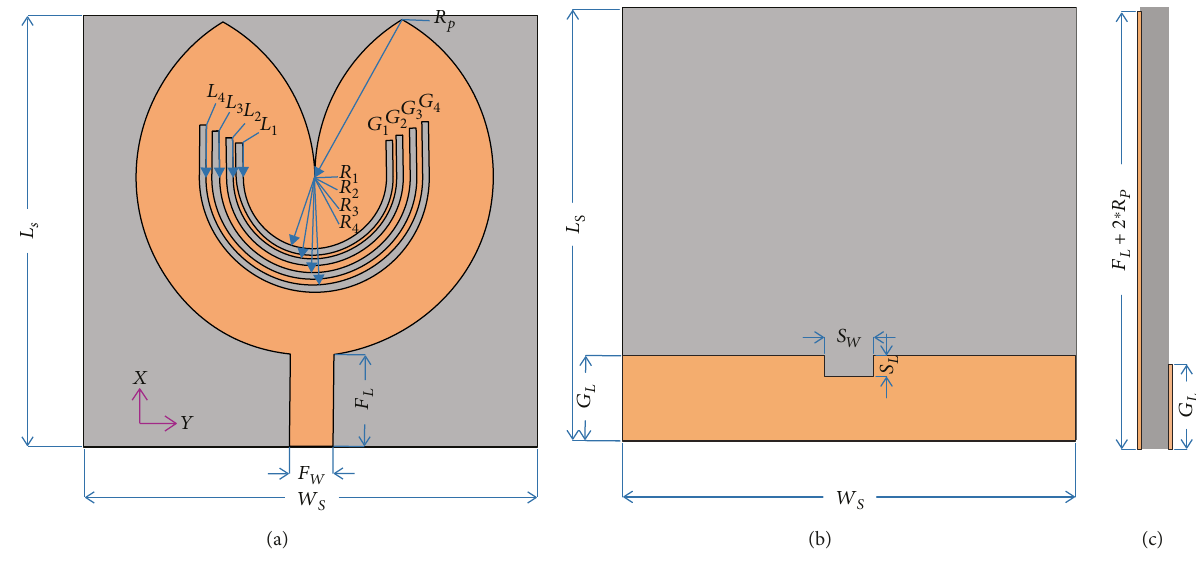
Figure 1: Proposed design. (a) Top view. (b) Back view. (c) Side view.